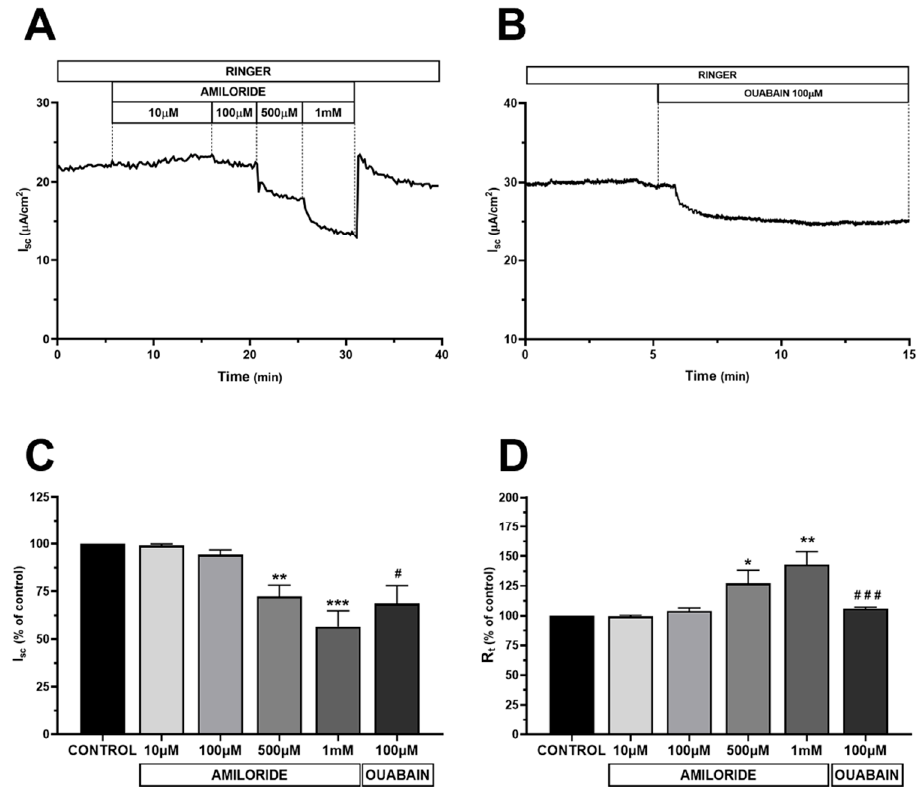
Figure 2. Functional polarization of HMC monolayers. ( A ) Representative trace of short circuit current (I sc ) showing that apical amiloride dose-dependently decreased I sc in HMC; ( B ) Representative trace recording of I sc demonstrating that basolateral addition of ouabain (100 µ M) in the bath solution induced a sustained decrease of I sc ; ( C , D ) Changes in I sc and R t , induced by Na + channels inhibition ( n = 4) and by Na + /K + -ATPase inhibition ( n = 3). Results are expressed as percentage of the I sc and R t basal value; Values are reported as mean values ± SEM. * p <0.05, ** p < 0.01, *** p < 0.001 vs. basal condition calculated by one-way analysis of variance (ANOVA) with Dunnett’s multiple comparison test. # p < 0.05, ### p < 0.001 vs. basal condition calculated by Student t-test.